Question: Reading the figure, is the described quantity rising or falling?
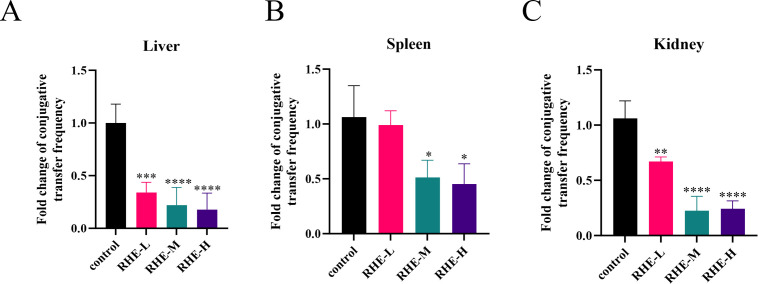
Answer: decreasing